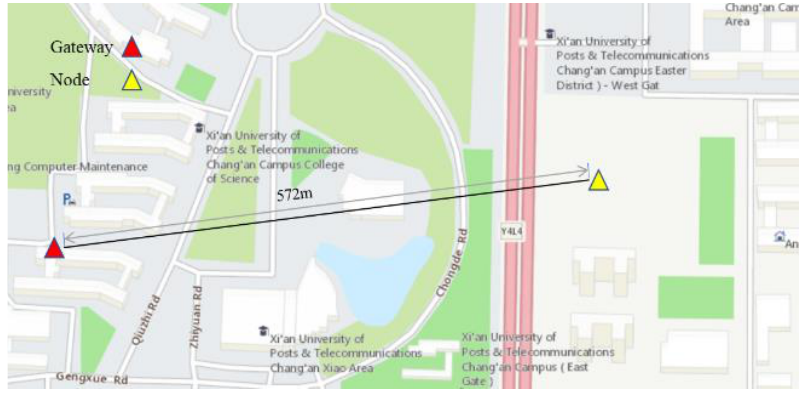
Figure 12. Experimental scenario 1.